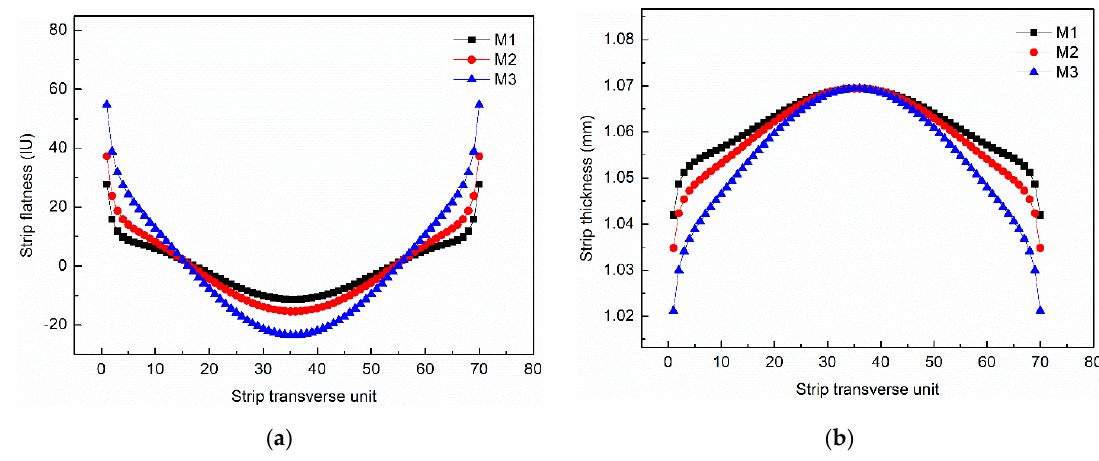
Figure 10. The ( a ) flatness and ( b ) thickness profile of S4 under different load distribution.